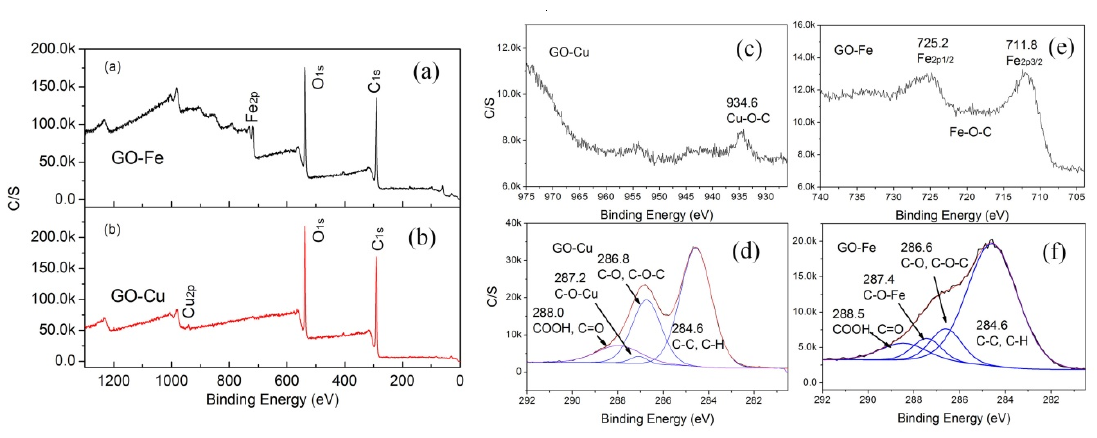
Figure 3. X-ray photoelectron spectroscopy ( XPS) binding energy spectra of ( a ) nGO-Fe, ( b ) nGO-Cu; ( c ) the Cu 2p spectra of nGO-Cu, without peak fitting; ( e ) the Fe 2p spectra of nGO-Fe, without peak fitting; the fitted C 1s peak curves for ( d ) nGO-Cu, and ( f ) nGO-Fe.